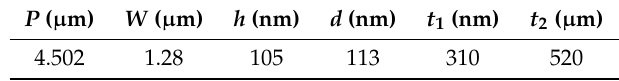
Figure 1. ( a ) Schematic of designed metagrating for octadecanethiol (ODT) detection. The relevant dimension parameters are P = 4.5 µm, W = 1.3 µm, h = 100 nm, d = 110 nm, t 1 = 300 nm, and t 2 = 500 µm. The incident light is TM-polarized in y – z plane. Top-view SEM images of the fabricated metagrating before ( b ) and after ( c ) ODT adsorption. Table 1. Geometric parameters of fabricated metagrating sample.